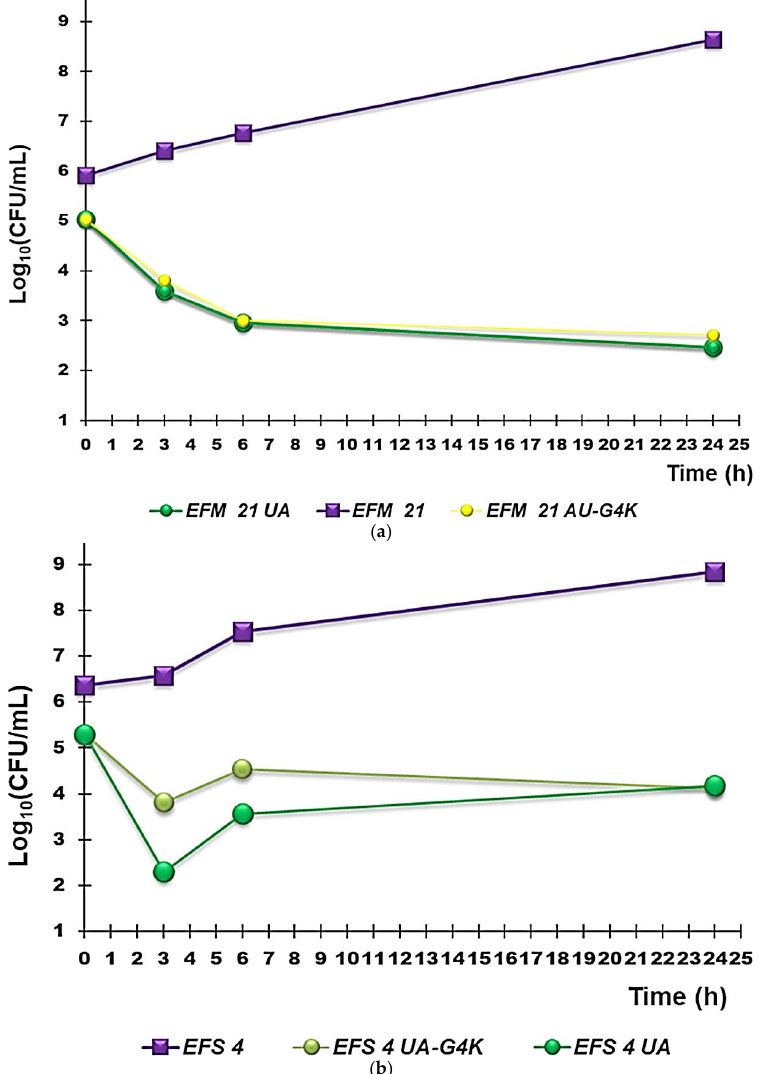
Figure 2. Time-killing curves performed with UA at concentration 10 µg/mL (5 × MIC) and with UA-G4K, at micromolar concentrations equal to those of UA (21.9 µM) on E. faecium 21 ( a ) and E. faecalis 4 ( b ). Overall, the results evidenced that, as reported in the study by Horiuchi [71], while UA was unequivocally bactericidal against E. faecium isolate, resulting in a log reduction > 3 after 24 h of exposure (Figure 2a), it was mainly bacteriostatic on E. faecalis 4. In fact, although against E. faecalis 4, it showed bactericidal effects after 3 h (4 logs reduction), steady regrowth began immediately and after 24 h, only a reduction of 2.2 logs was ob- served (Figure 2b). Concerning UA-G4K NPs, after 24 h of exposure, effects identical to